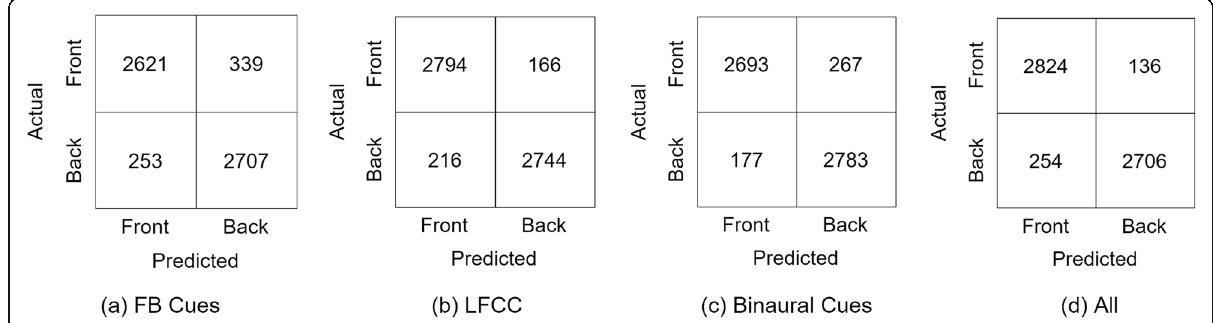
Fig. 5 Examples of confusion matrices obtained for a literature-inspired front-back cues, b linear-frequency cepstral coefficients, c binaural cues, and d combination of all features. The results were achieved using Logit